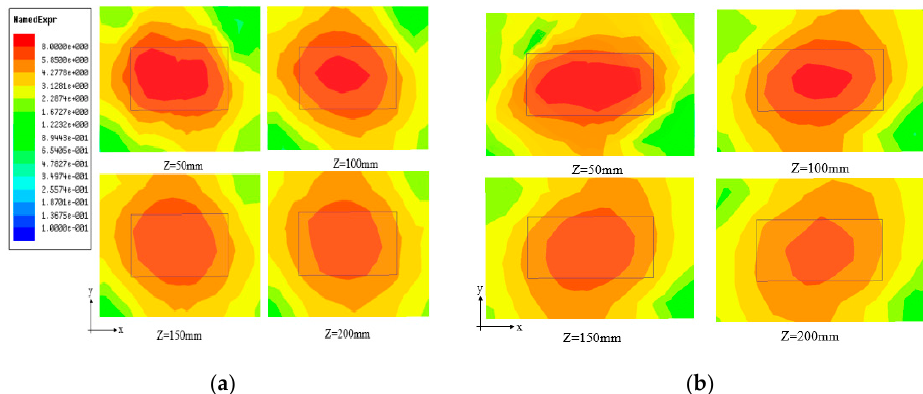
Figure 25. Simulated distribution of electric field components (Ex, Ey) at different heights for a 1 × 2 array antenna: ( a ) Ex distribution and ( b ) Ey distribution.